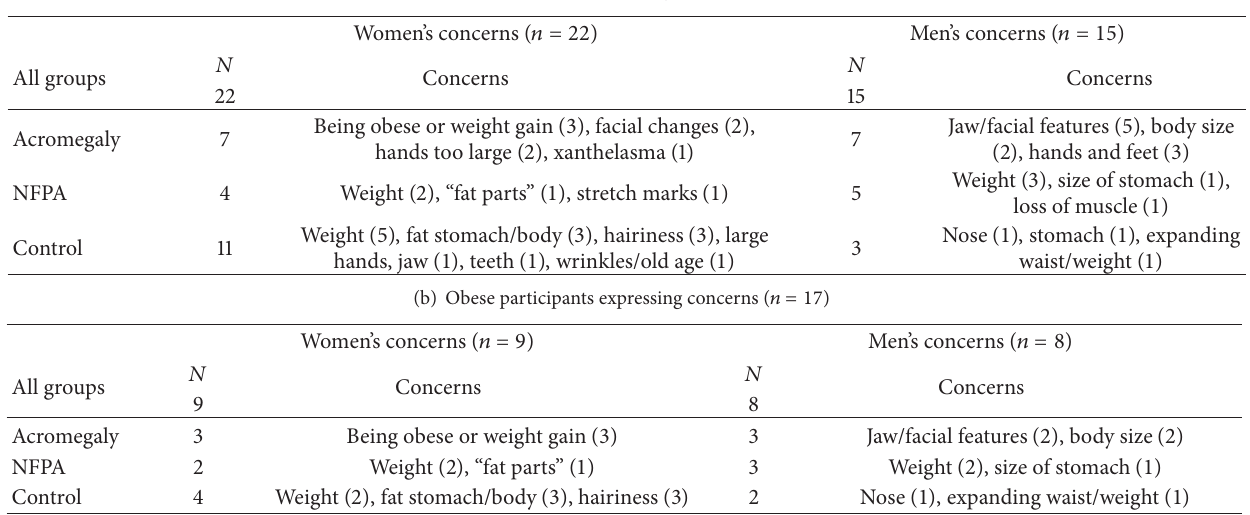
Table 3: Self-reported appearance concerns on the BIDQ by group.